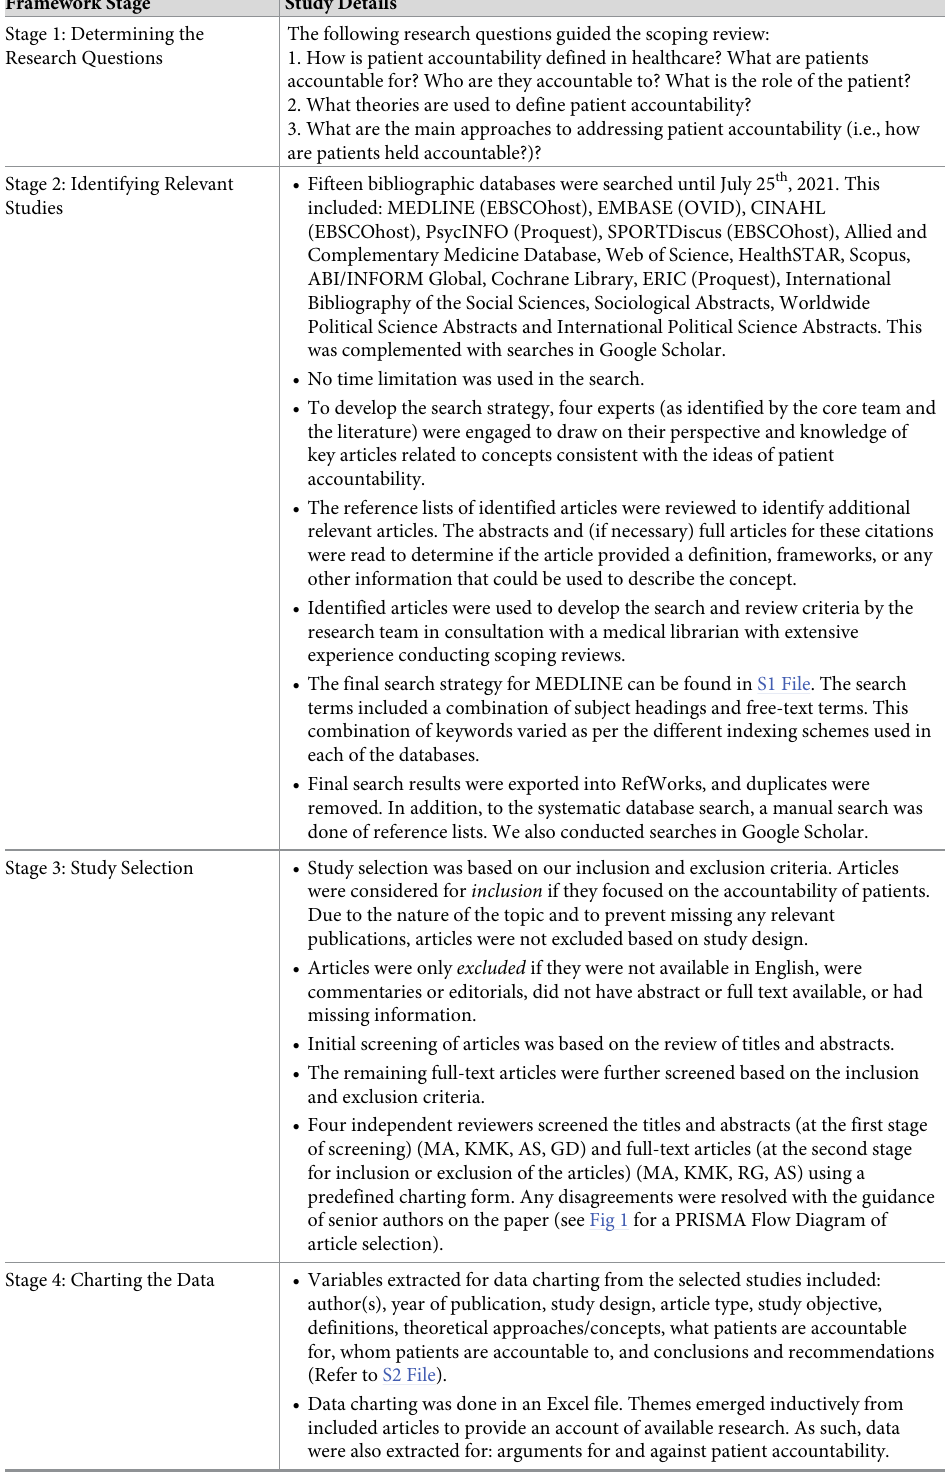
Table 1. Methodology guiding the scoping